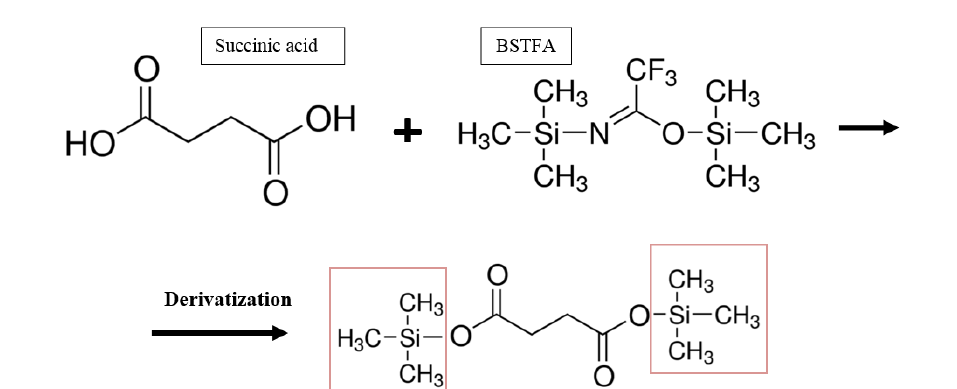
Fig. 1. Overall scheme of chemical derivatization of succinic acid by silylation using -bis- (trimethylsilyl) - trifluoroacetamide (BSTFA)